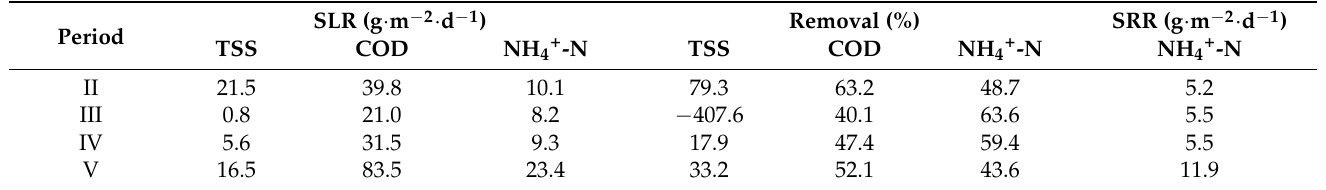
Table 2. Net surface loading rate received and removed by the VF